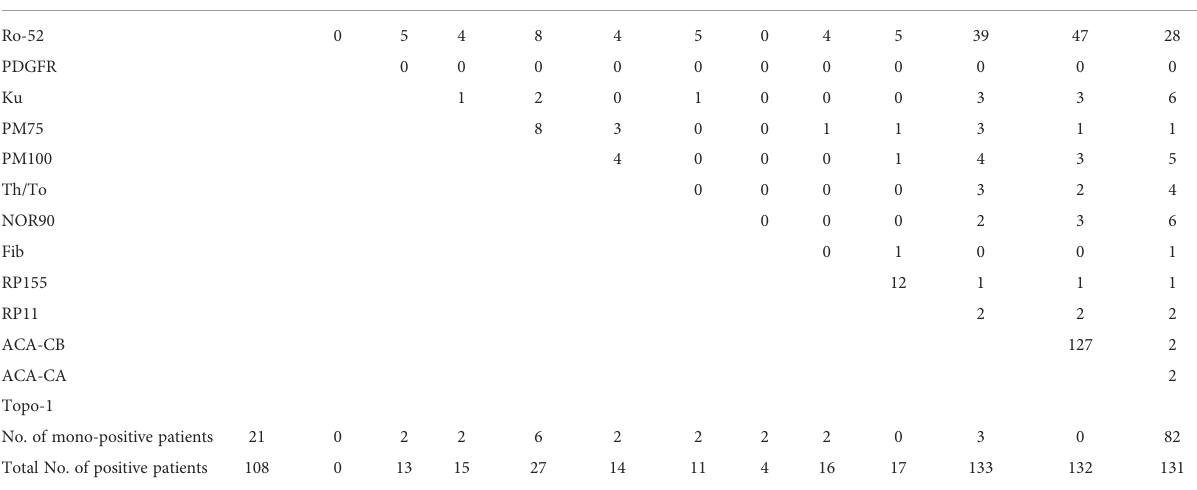
TABLE 2 Numbers and combinations of autoantibodies identi fi ed in the 372 SSc